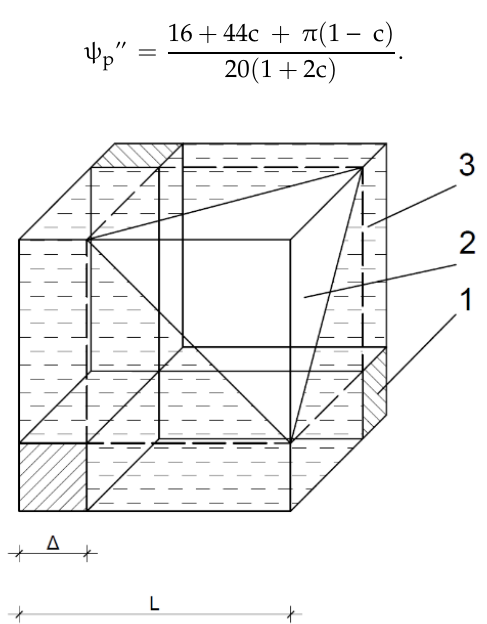
Figure 2. The eighth part of the unit cell at the boundary moisture ψ p ʹʹ and contact angle θ = 45°; 1,2,3—solid, gas and liquid component of the structure, respectively.